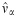
Illustration of intra-subject variability.(Top) For each stimulus level x the distribution of proportion correct is plotted as a heat map based on 1000 templates created with the population average model (bold black sigmoid) and the intra-subject variability models using ν^α and ν^β. (Middle) The dashed black distribution curves correspond to the parametric log–normal and beta intra-subject variability models. The histograms (black outline) as well as the dashed black lines for the means show the parameter distributions of the 1000 templates including intra-subject variability. The white triangles indicate the threshold and slope of the population average model (without noise). As a comparison, the inherent method variability (histogram with gray fill) for the same population average model without intra-subject variability is plotted. (Bottom) The percentage of estimates within a tolerance interval (percentage within bounds, PCTw/iB) around the parameters of the population average model is plotted against the size of the interval (gray: method variability, black: intra-subject variability), together with the absolute difference of percentage (|Δ|, dashed black line). For both method and intra-subject variability, the normalized area under the curve (nAUC) is calculated.